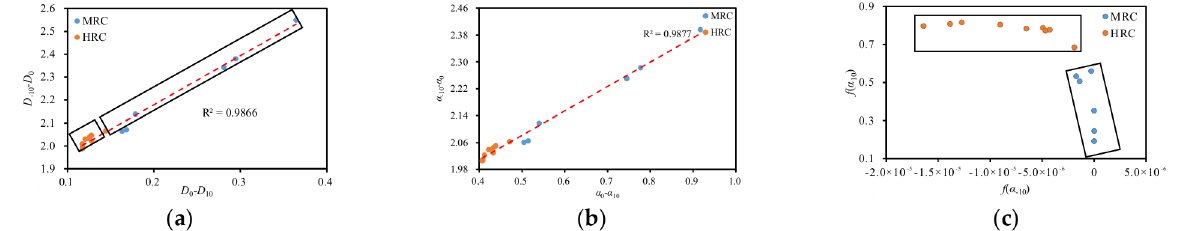
Figure 8. The relationships between ( a ) D 0 - D 10 vs. D -10 - D 0 ; ( b ) α 0 - α 10 vs. α -10 - α 0 and ( c ) f ( α -10 ) vs. f ( α 10